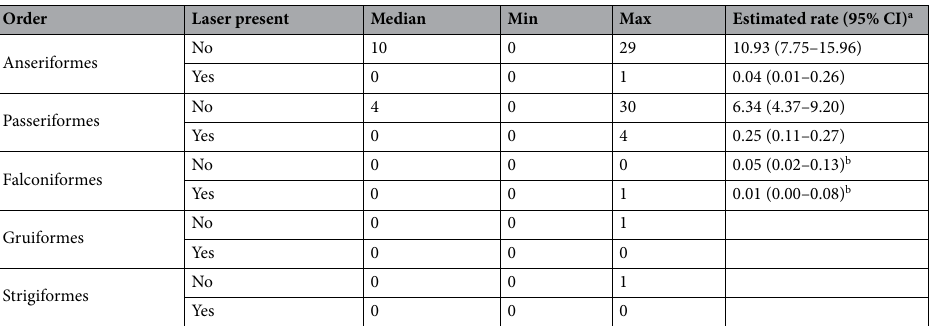
Table 1. Summary of daily numbers of wild birds visiting during the experimental periods (28 observation days with and 29 days without the laser in operation), grouped by taxonomic Order, observed in the free-range study area. a Estimated mean rates of visits [95% Confidence Intervals (CI)] using a generalized linear model with negative binomial distribution. b These rates represent the estimated rates of visits for the three Orders Falconiformes, Gruiformes, Strigiformes